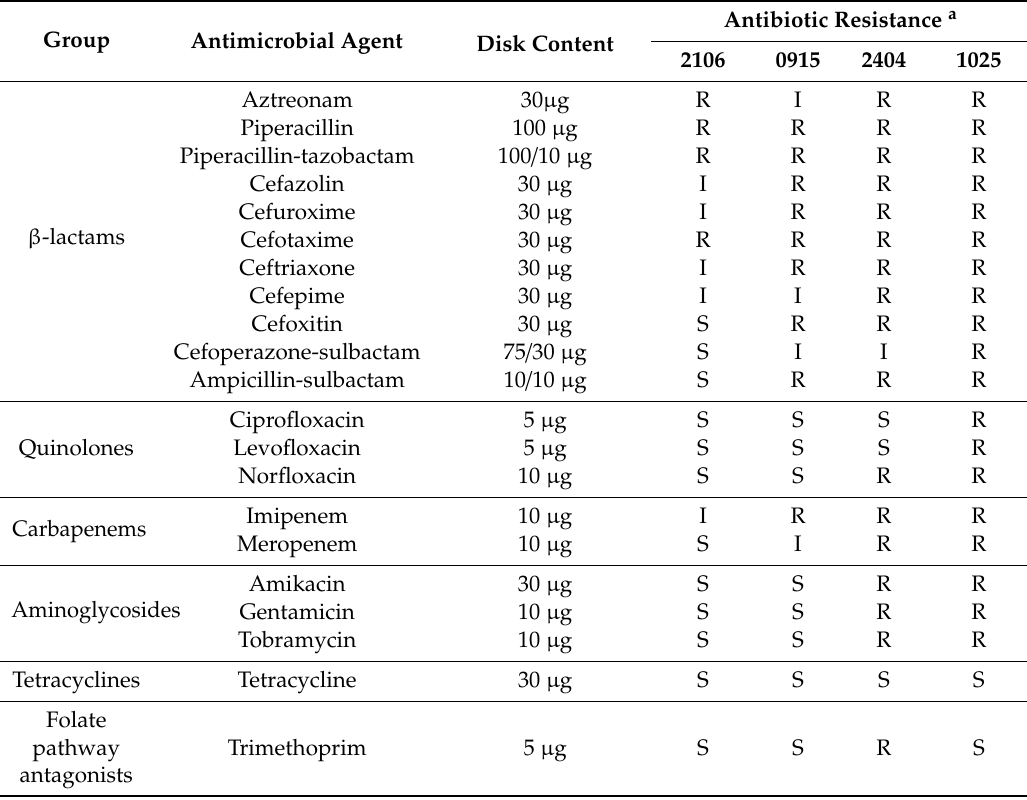
Table 2. Antimicrobial susceptibility tests of the Klebsiella pneumoniae strains used in this study.